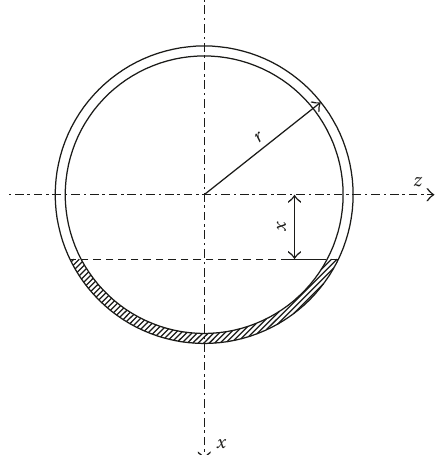
Figure 5: Sketch for mechanical analysis of the annular girder suffering shearing